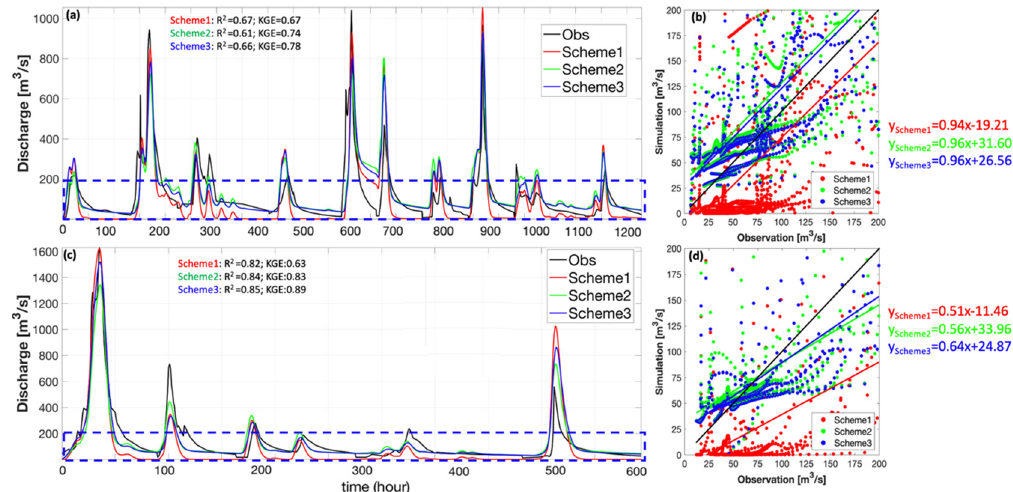
Figure 9. Comparison between observed and simulated streamflow with calibration scheme 1, scheme 2 and scheme 3, subplots ( a ) and ( b ) are for calibration and subplots ( c ) and ( d ) are for validation. The dashed blue boxes highlight base-flow simulation, which are presented by scatter plots ( b ) and ( d ).